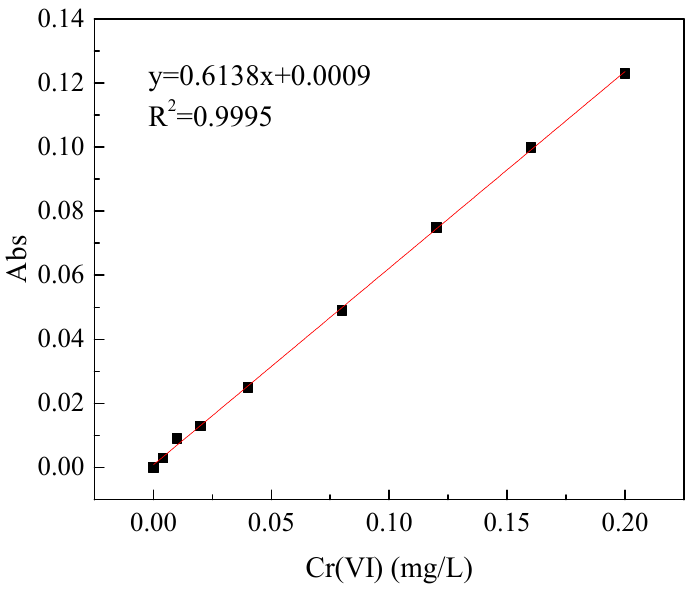
Figure 2. The calibration curve of Cr(VI) concentration.